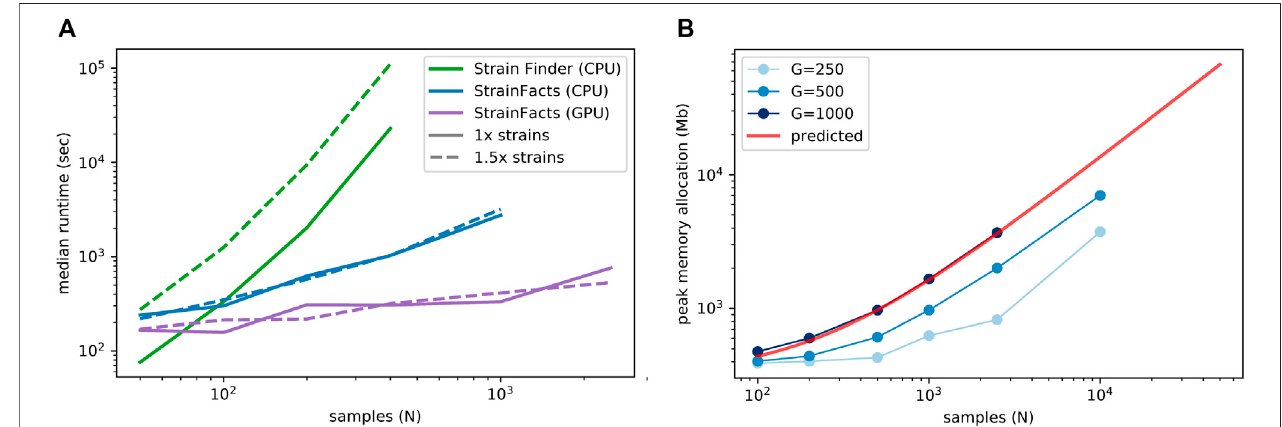
FIGURE1| Computationalscalabilityofstraininferenceonsimulateddata. (A) Runtime(inseconds,logscale)isplottedatarangeofsamplecountsforbothStrain Finder and StrainFacts, as well for the latter with GPU acceleration. Throughout, 250 SNPs are considered, and simulated strains are fi xed at a 1:5 ratio with samples. Models are speci fi ed with this same number of strains ( “ 1x strains ” , solid lines) or 50% more ( “ 1.5x strains ” , dashed lines). Median of 25 simulation runs is shown. (B) Maximum memory allocation in a model with 100 strains is plotted for StrainFacts models across a range of sample counts (N) and SNP counts (G, line shade). Median ofninereplicaterunsisshown.Maximummemoryrequirements areextrapolatedtohigher numbersofsamplesforamodelwith1,000SNPs(redline).Aversion of this panel that includes a range of strain counts is included as Supplementary Figure S2